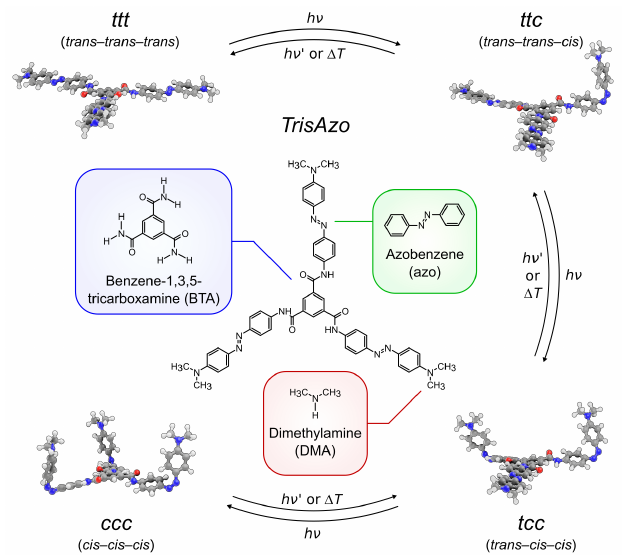
Figure 1. Chemical structure of TrisAzo (center) with its constituent groups highlighted in different colors. Around it, the four isomers of TrisAzo are shown as renderings from 3D models. The conformers of tcc and ccc , which have cis -azo arms pointing in different directions, are omitted. The molecular structures are visualized using a combination of the 3D graphics software Blender [49], the plugin BlendMol [50], and the MD visualization tool VMD